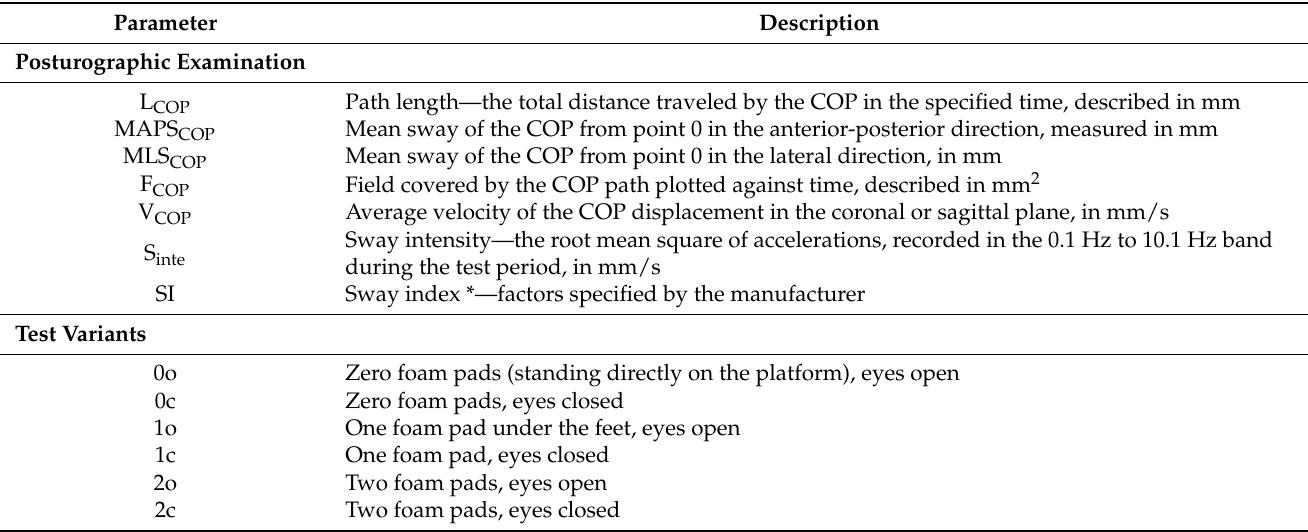
Table 7. Characteristics of the parameters and the test variants of the posturographic